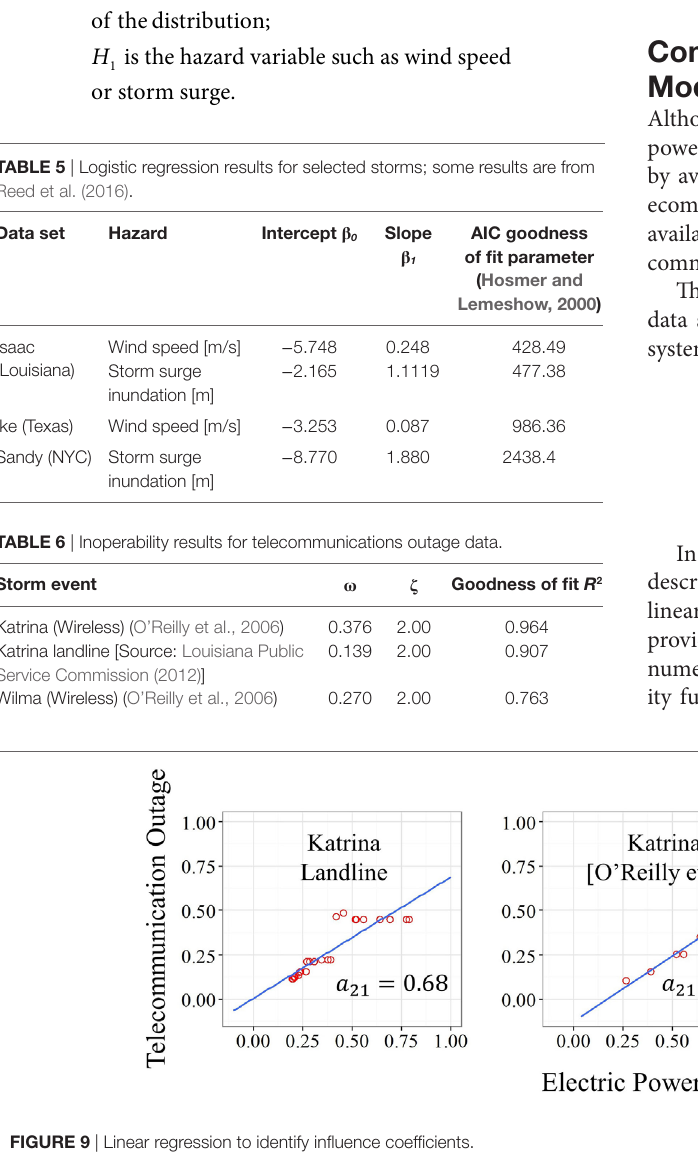
FigUre 9 | Linear regression to identify influence coefficients.